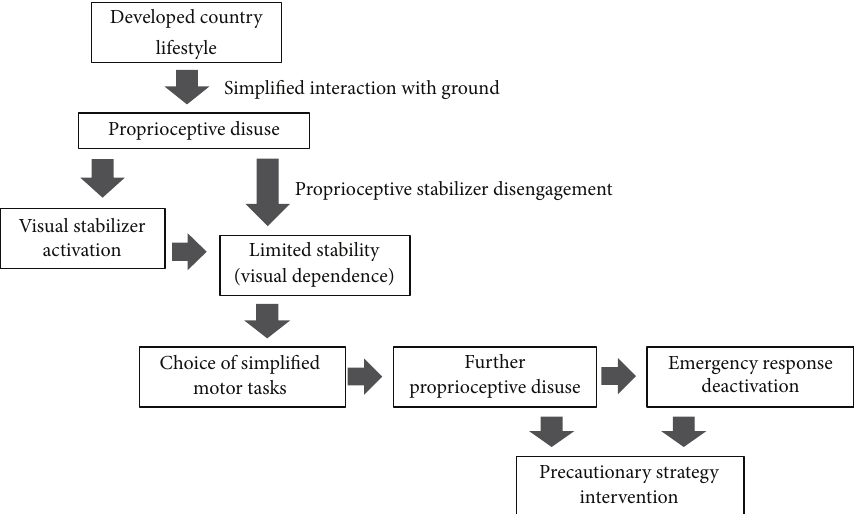
Figure 5: Causal chain of proprioceptive disuse and consequences. The sequence highlights how the intervention of vision as compensatory stabilizer leads to further proprioceptive